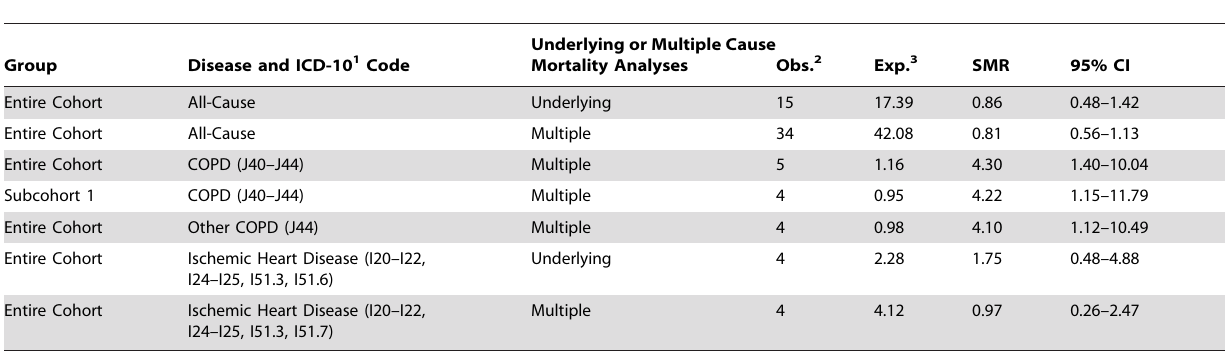
Table 4. Standardized mortality ratios (SMR) for microwave popcorn production